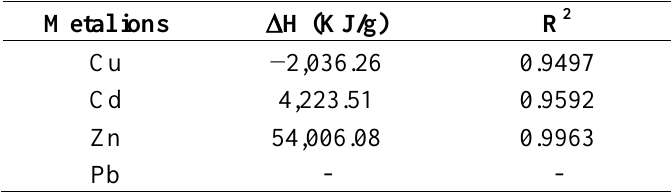
Table 2. Correlation coefficient (  H) and correlative parameter (R 2 ) of adsorption of the four metal